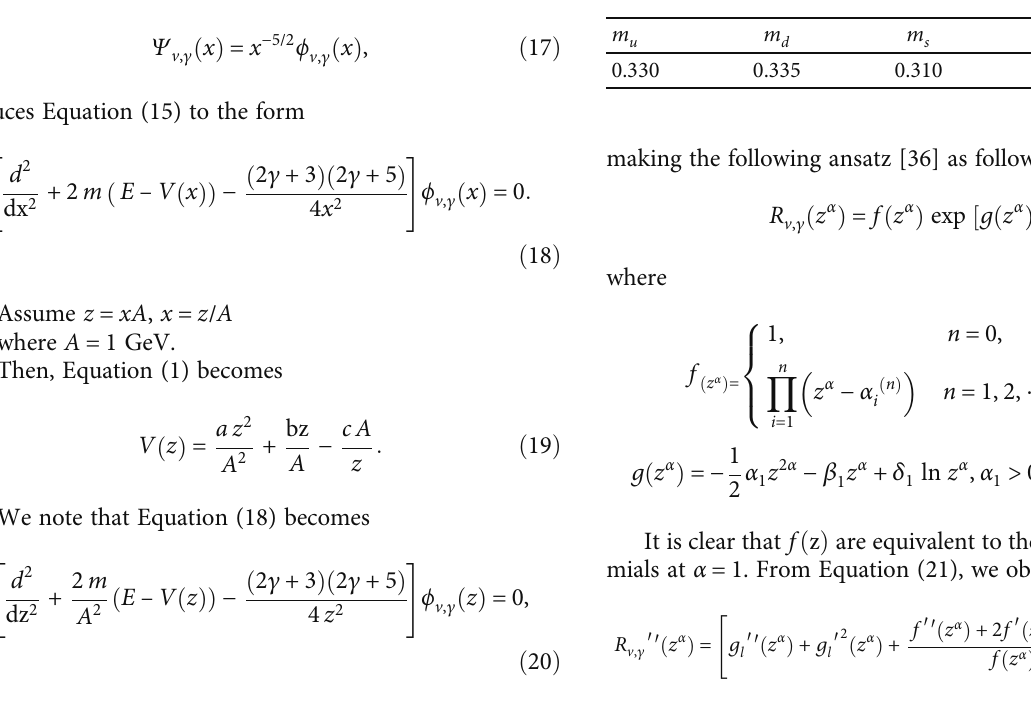
Table 2: The values of the used quark masses in two cases in GeV